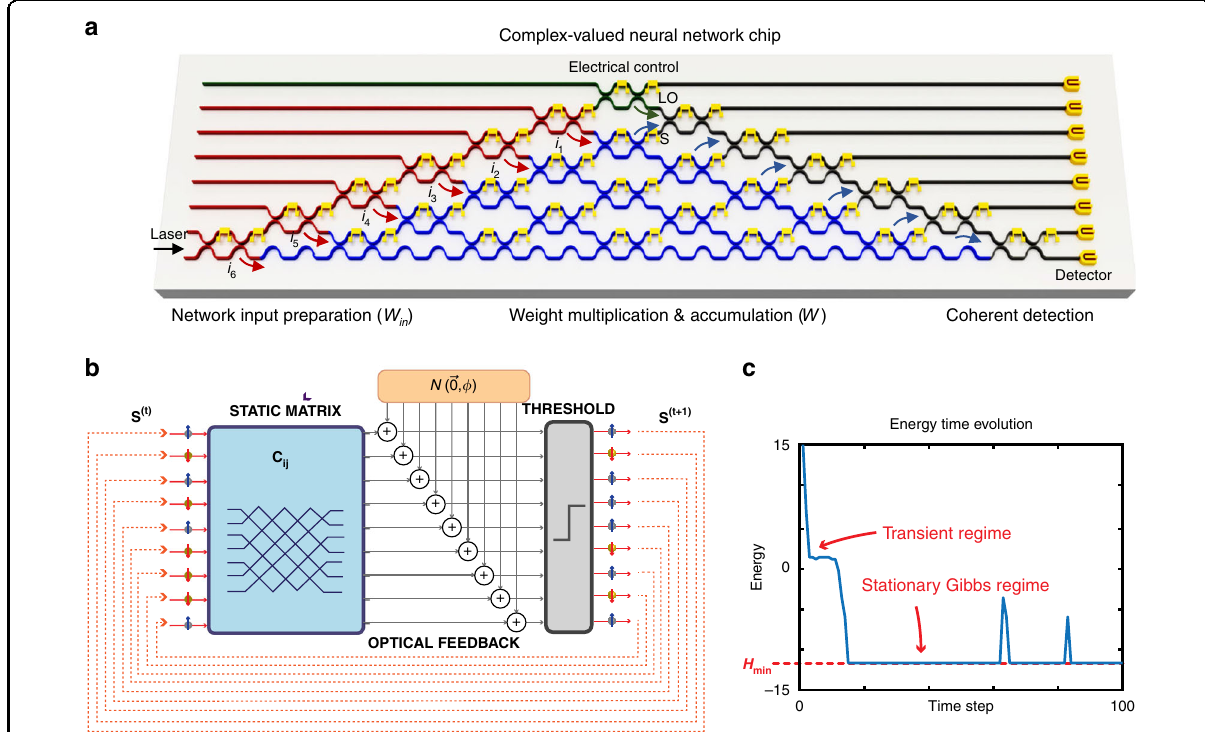
Fig. 11 MZI-MVMs for complex-valued ONN and photonic Ising machines. a Complex-valued ONN with MZI mesh 77 . b , c Photonic recurrent Ising machines with MZI mesh 74 . b The principle of Ising machines and c the energy evolution as a function of time. a Reprinted from ref. 77 with permission from Springer Nature: Nature Communications. b , c Reprinted with permission from ref. 74 © The Optical